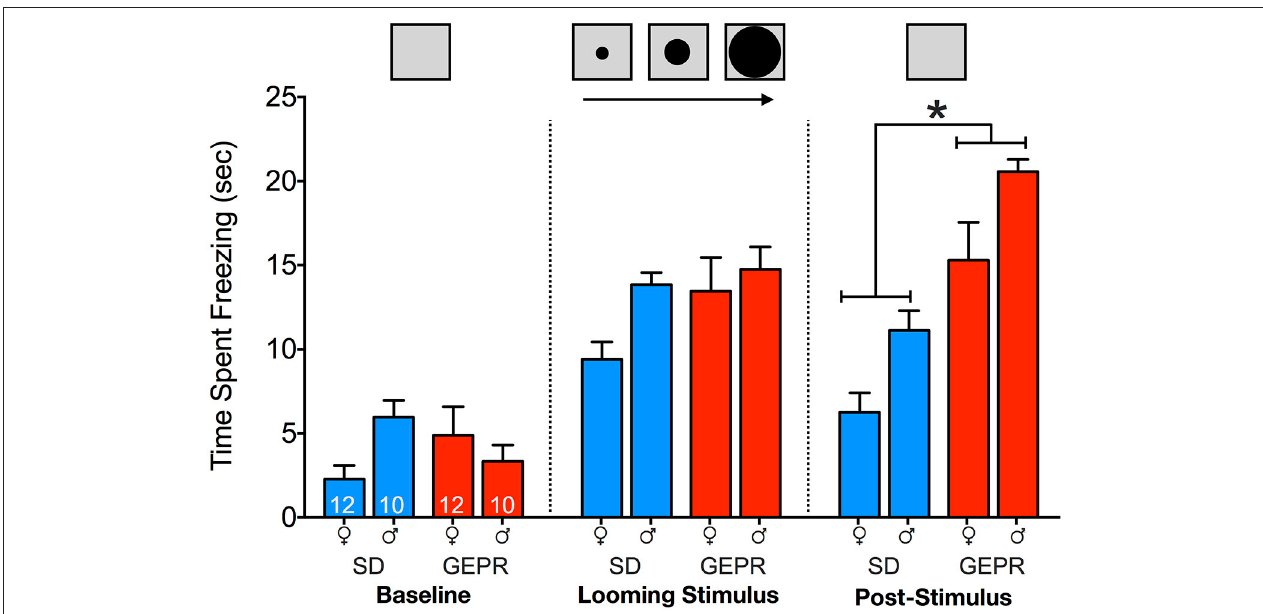
FIGURE 4 | Looming threat test. Time spent freezing during: baseline period (22s prior to stimulus presentation), presentation of looming stimulus (22s), and in the post-stimulus period (22s immediately after stimulus presentation). Overall, GEPR-3s spent more time frozen [ F (1,40) = 11.7, P = 0.001], but there was no effect of sex ( P = 0.12). During the post-stimulus period, there was a significant increase in freezing in GEPR-3s as compared to SD rats (*Holm-Sidak Adjusted, Females: P = 0.0004 and Males: P = 0.0007). Figures show mean and standard error of the mean.